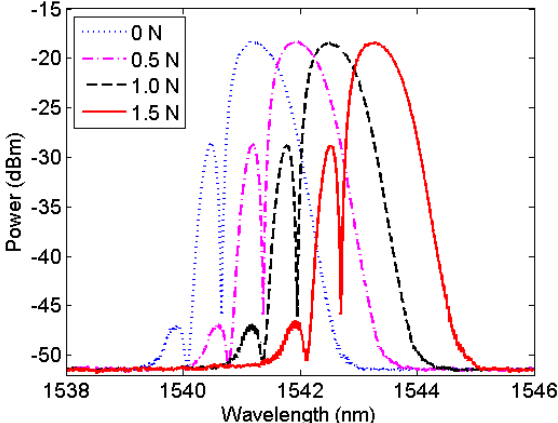
Figure 1. Power wavelength spectrum measured with the interrogation system while mechanically pulling an optical fiber with a Bragg grating. The force is monitored by an electronic dynamometer.